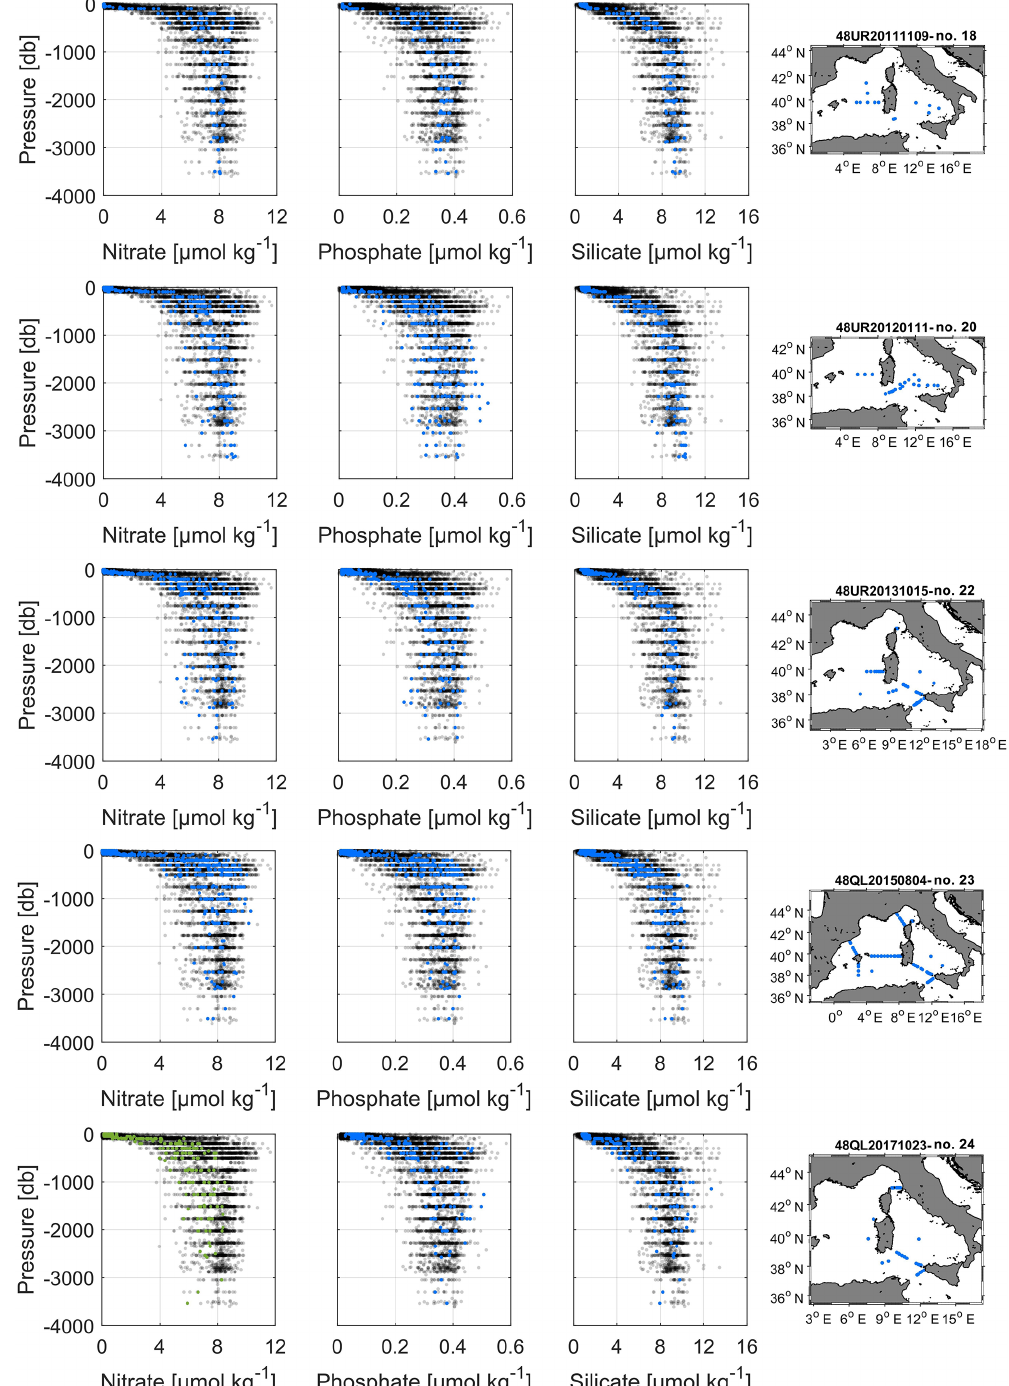
Figure 9. Vertical profiles of the inorganic nutrients in the dataset after adjustments and spatial coverage of each cruise (reference to cruise ID is above each map). The whole WMED adjusted product is shown in black, while the data of each individual cruise are shown in blue (flag 2) and green (flag